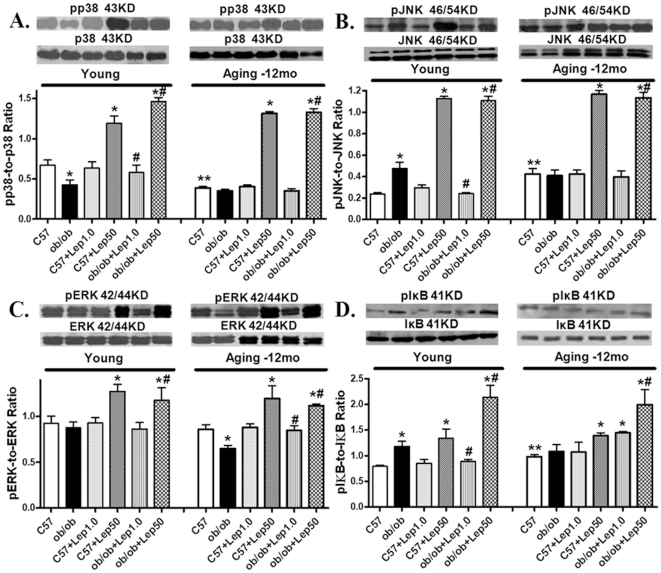
Total and phosphorylated protein expression of p38 MAP kinase, JNK,
ERK and IκB in cardiomyocytes isolated from young (4-month-old)
or aging (12-month-old) lean (C57) and ob/ob mice
treated with or without leptin (1.0 and 50 nM) for 4 hrs.Panel A: Phosphorylation of p38 expressed as pp38-to-p38 ratio; Panel B:
Phosphorylation of JNK expressed as pJNK-to-JNK ratio; Panel C:
Phosphorylation of ERK expressed as pERK-to-ERK ratio; and Panel D:
Phosphorylation of IκB expressed as p IκB-to-IκB
ratio. Insets: Representative gel blots of total and phosphorylated p38,
JNK, ERK and IκB proteins using specific antibodies. Mean
± SEM, n = 4–8
isolations, * p<0.05 vs. respective C57
group, ** p<0.05 vs. young C57
group, # p<0.05 vs. respective
ob/ob group.